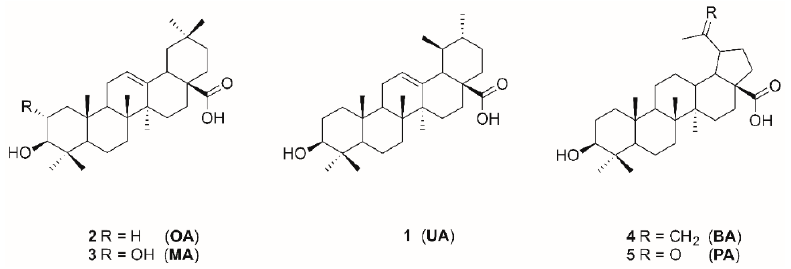
Figure 1. Structures of triterpenoic acids 1 – 5 .